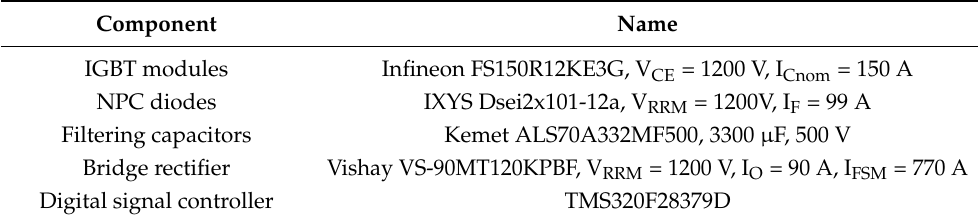
Table 5. The list of main components of the prototype inverter. Component